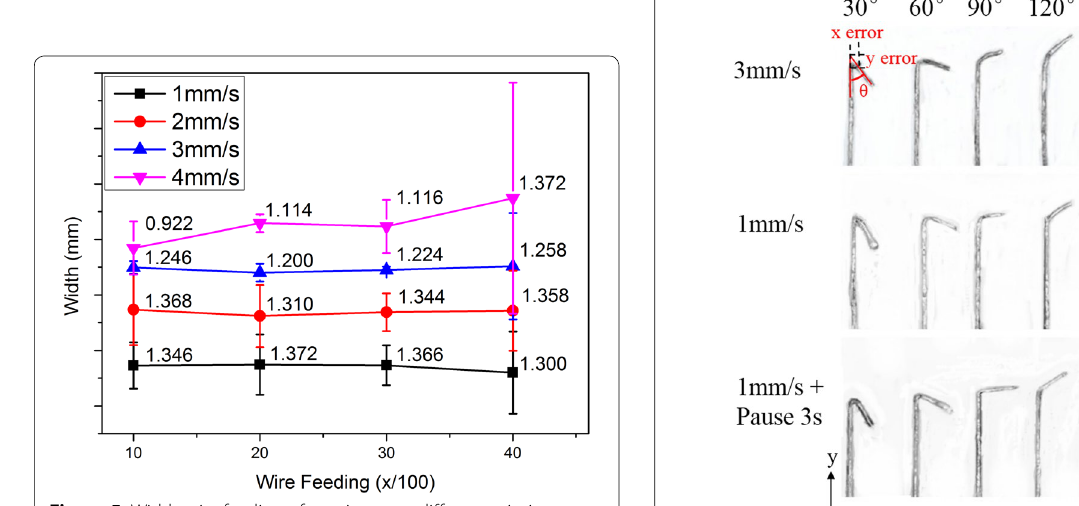
Figure 5 Width-wire feeding of specimens at different printing velocities